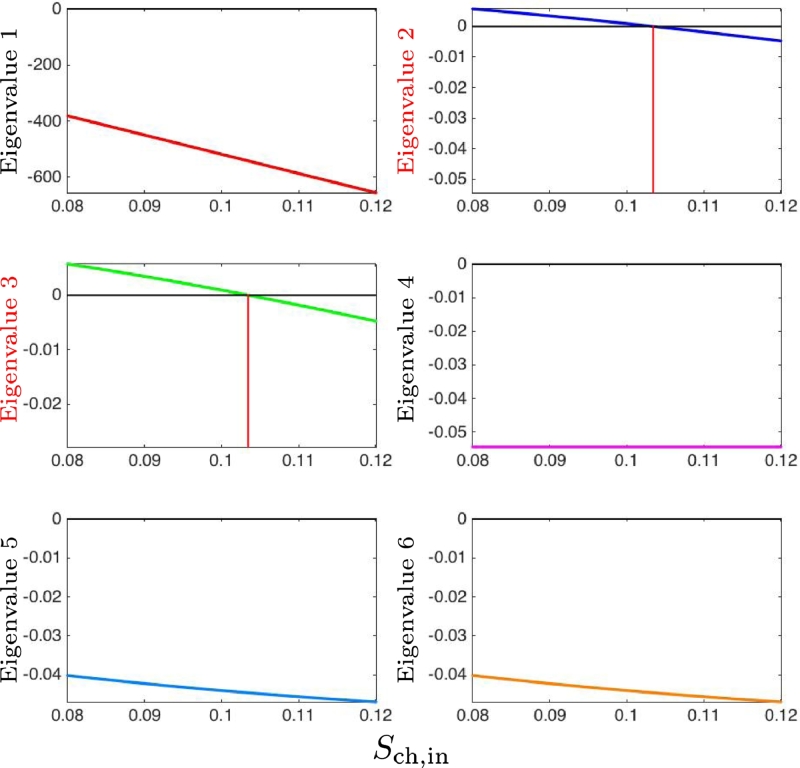
Real parts of the eigenvalues determined at D=0.01 and Sch,in=[0.08,0.12], in the case with maintenance. The red vertical lines indicate the location where the eigenvalue crosses zero. (For interpretation of the references to colour in this figure legend, the reader is referred to the web version of this article.)